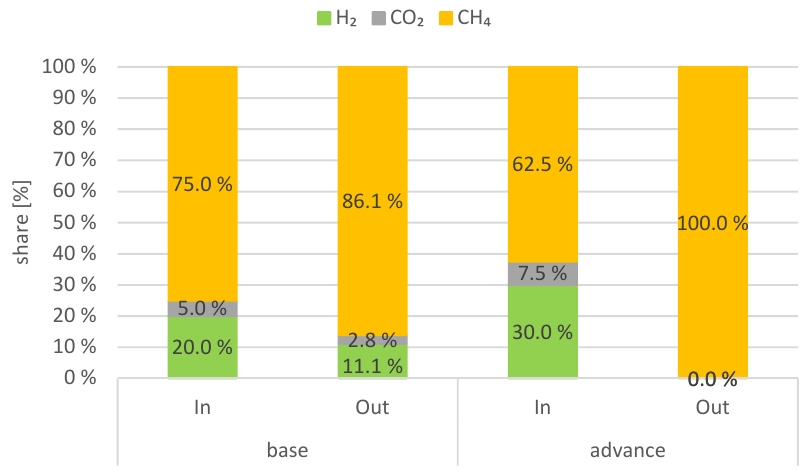
Figure 4. Gas composition (proportion of CH 4 , H 2 and CO 2 ) during injection and withdrawal. In the plant configuration base, 20% H 2 , 5% CO 2 and 75% CH 4 are stored in the underground pore storage. After the conversion, the output volume flow consists of 11.1% H 2 , 2.8% CO 2 and 86.1% CH 4 . Thus, the share of CH 4 in the overall mixture is increased by 11.1 percentage points. In comparison, a significantly higher proportion of H 2 (30%) is stored in the advance plant configuration. Similar to the plant configurations base, CO 2 is added stoichiometrically (7.5%). The remaining share in the volume flow is accounted for CH 4 (62.5%). In the advance plant configuration, it is assumed, that all H 2 and CO 2 is converted to CH 4 , which means that 100% CH 4 is available at withdrawal.